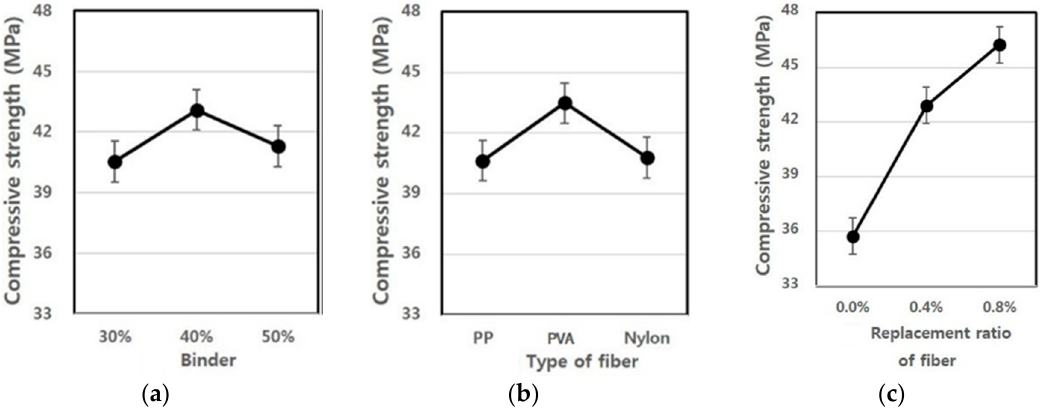
Figure 10. Assumed compressive strength of the extrusion panel by variance analysis: ( a ) replacement ratio of binder; ( b ) type of fiber; ( c ) replacement ratio of fiber.